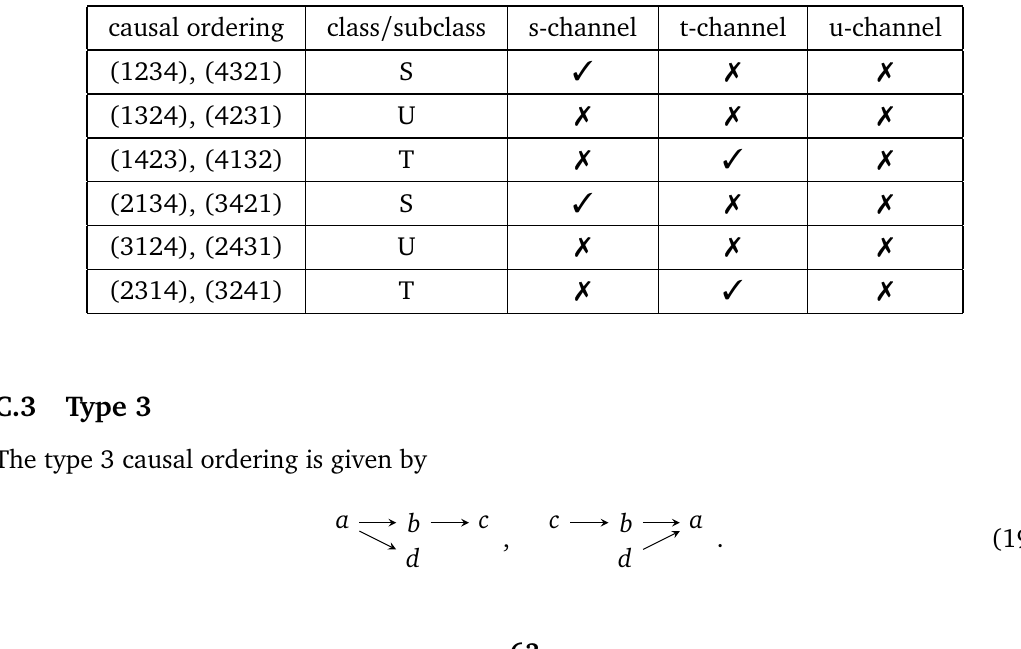
Table 6: OPE convergence properties of type 2 causal